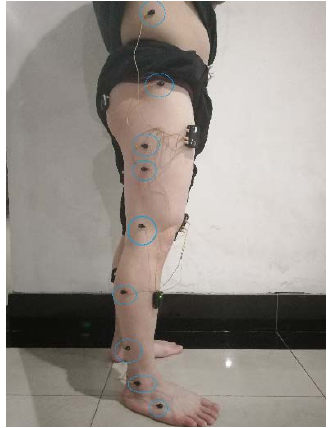
Figure 9. Codamotion marker placement.